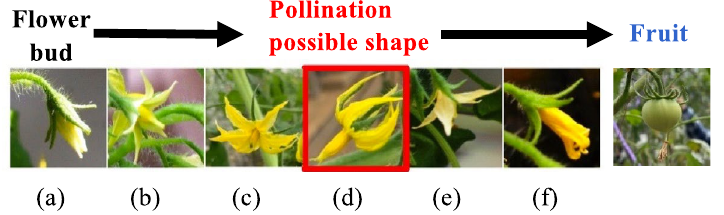
Figure 2. Flowering process and conditions for determining flower shapes of flowers ready for pollination. The process of tomato flower budding, flowering, and fruiting. The process from ( a ) to ( f ), ( a ) is the start of a bud, and fruits grow after ( f ).